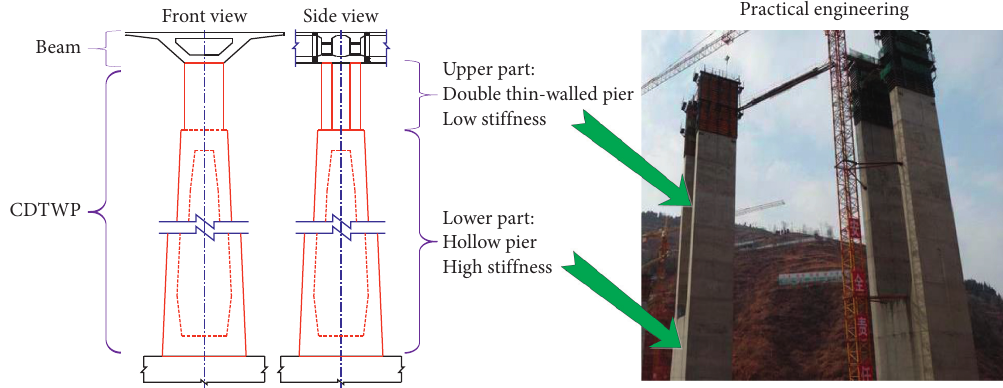
Figure 1: Combined double thin-walled pier